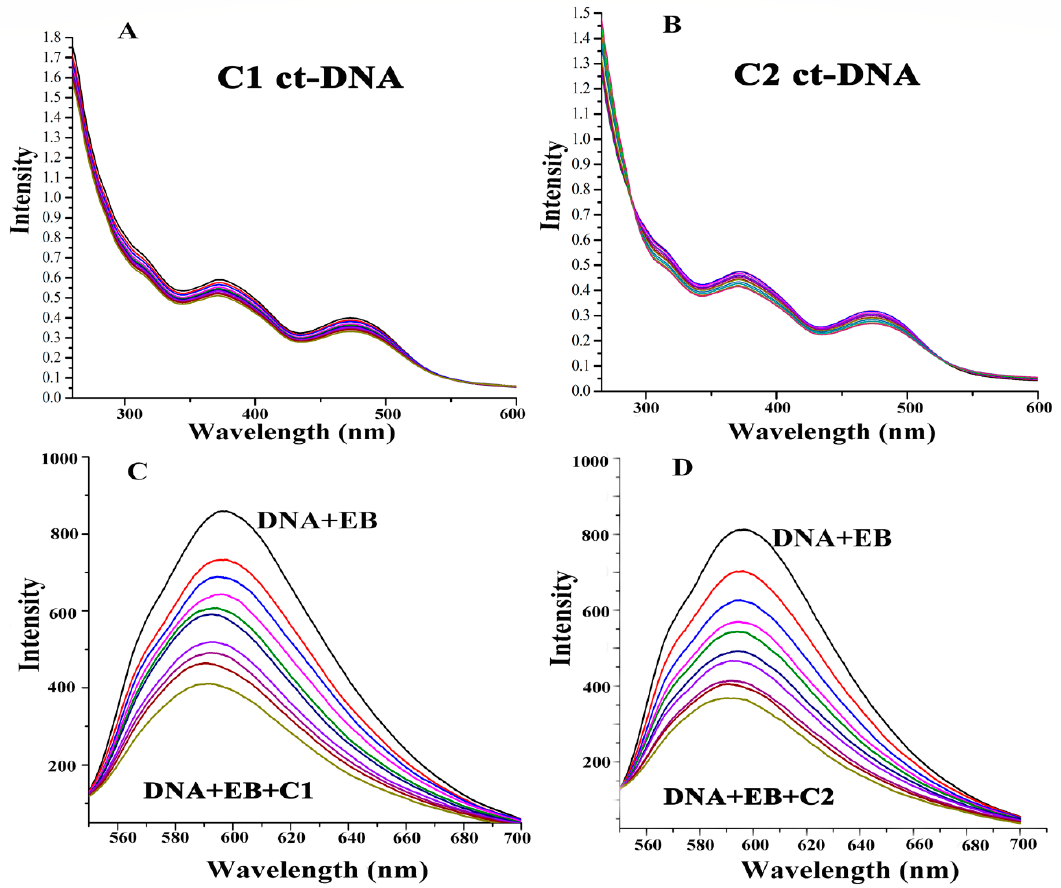
Figure 11. ( A ) UV-Vis titration of 5 μ M C1 with ct-DNA in 10 mM Tris-HCl (7.4). ( B ) UV-Vis titration of 5 μ M C2 with ct-DNA in 10 mM Tris-HCl (7.4). ( C ) Effect of C1 on the emission intensity of EB (8 μ M) bound to ctDNA (10 μ M) in pH 7.2 Tri-HCl buffer. ( D ) Effect of C2 on the emission intensity of EB (8 μ M) bound to ctDNA (10 μ M) in pH 7.2 Tri-HCl buffer.